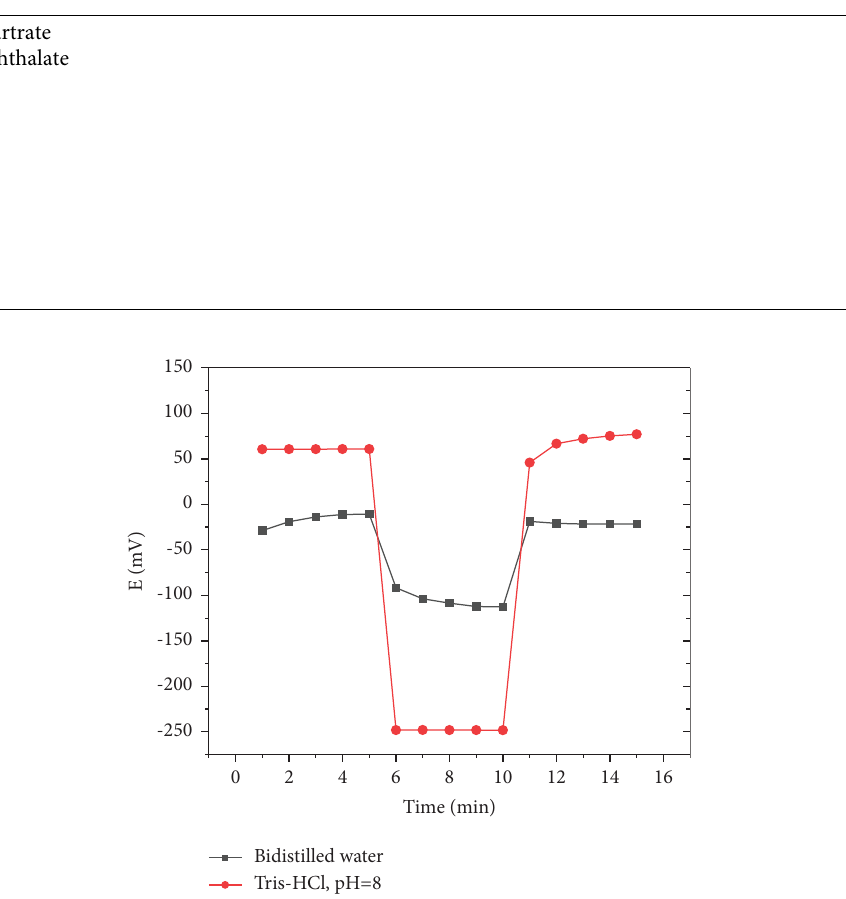
Figure 8: Te layer efect study on the response of the terbinafne microchip from 10 − 5 mole · L − 1 terbinafne in bi-distilled water and tris- HCl bufer, pH 8. Table 3: Terbinafne microchip potentiometric parameters.